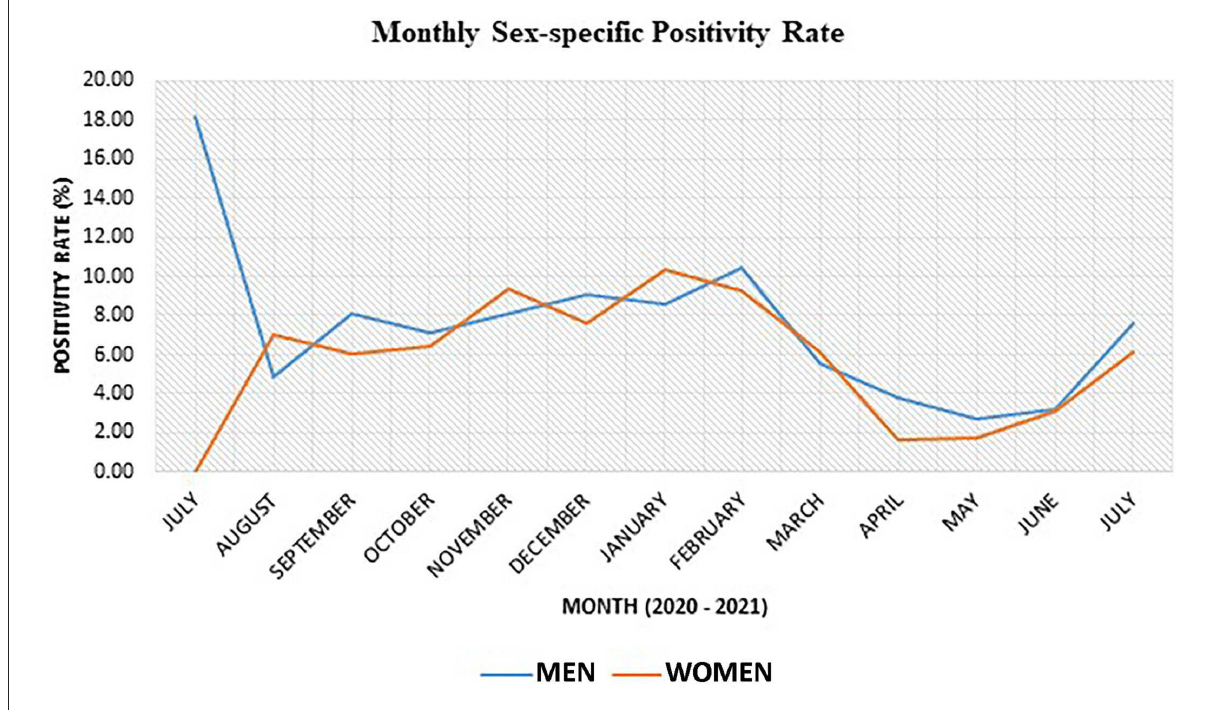
FIGURE3 Sex-specific SARS-CoV-2 positivity rate for various months within the study